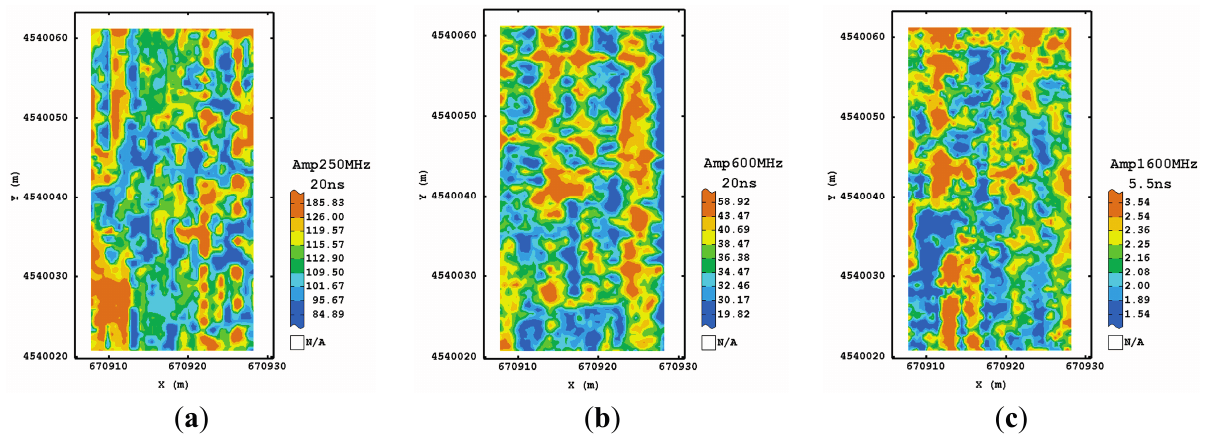
Figure 6. Maps of estimated amplitude for 250 MHz ( a ); 600 MHz ( b ) and 1600 MHz ( c ) frequencies using the first processing procedure corresponding to their maximum depth investigated. (Colour scale uses iso-frequency